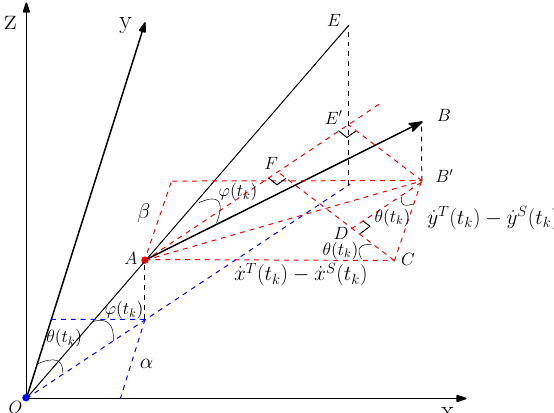
Figure 1. Geometry for Doppler-angle tracking in a three-dimension